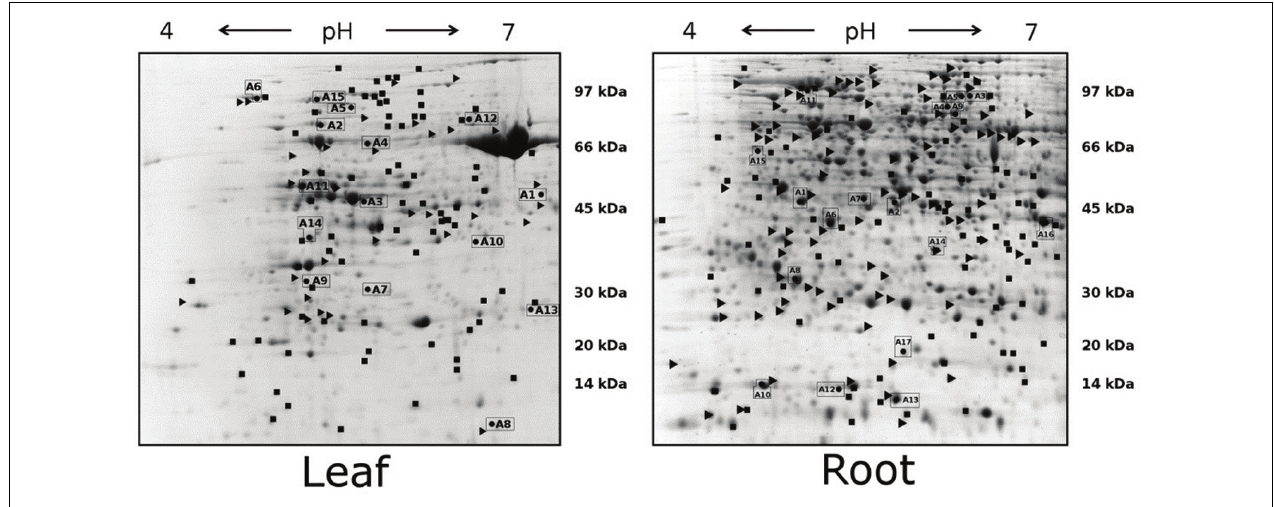
FIGURE 2 | Two-dimensional electrophoretic gels obtained during analysis of protein extracts from barley leaves and roots. Protein samples were separated on an immobilized pH gradient strip, followed by SDS-PAGE. Labels indicate drought responsive proteins: ( (cid:4) ) – Maresi; ( (cid:73) ) – Cam/B1/CI. Spots enclosed in rectangles represent proteins whose accumulation levels changed following drought treatment in both tested barley